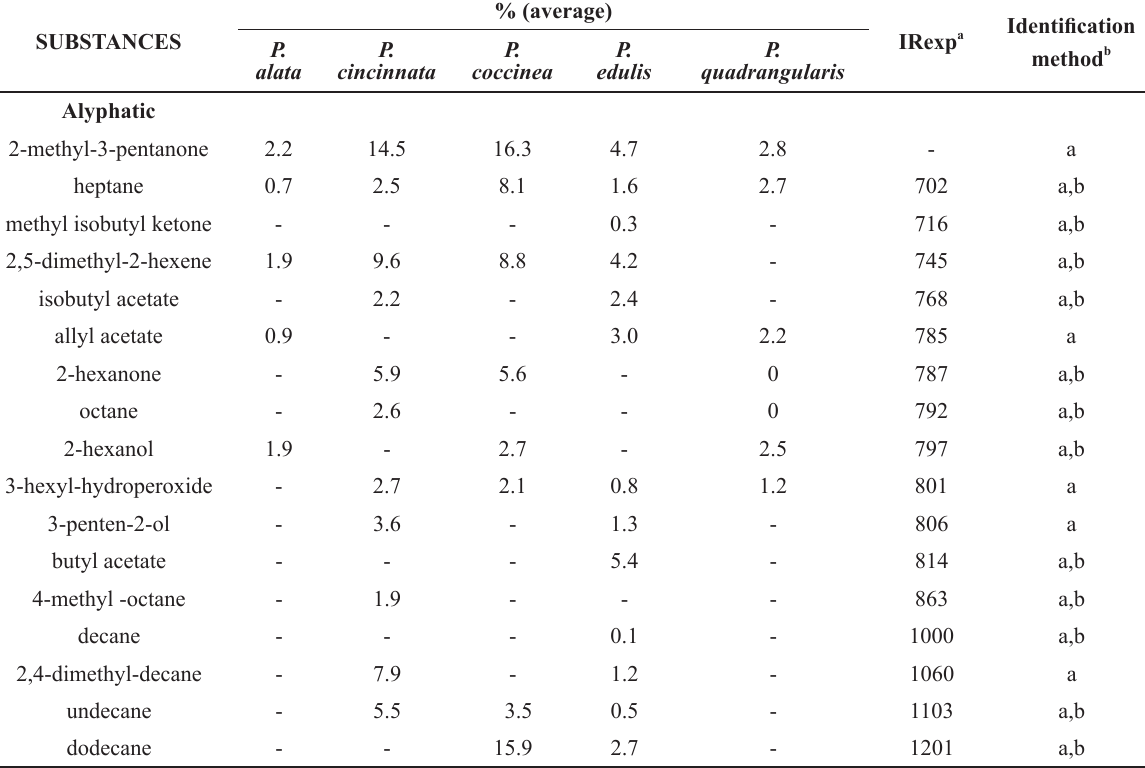
Floral volatiles identified from Passiflora